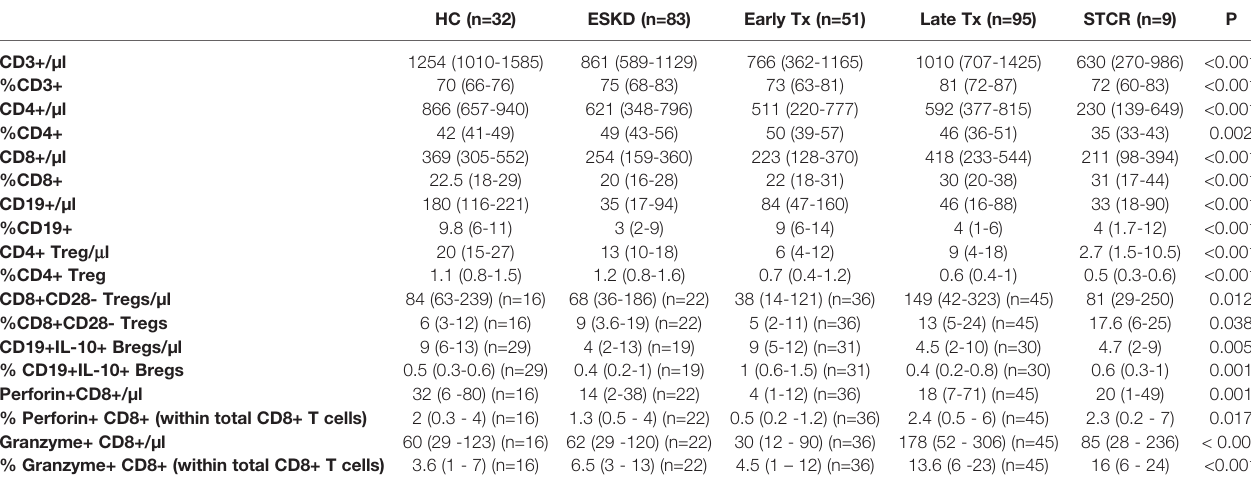
TABLE 2 | Comparison of the absolute and relative counts of CD4+, CD8+ T cells, CD4+CD25+CD127-Foxp3+ and CD8+CD28- Tregs, IL-10+CD19+ B, perforin+, and granzyme B+ CD8+ T cell subsets in healthy controls (HC), end-stage kidney disease patients (ESKD), early and late renal transplant (Tx) patients, and renal transplant patients with a relatively recent steroid-treated acute cellular rejection (STCR).